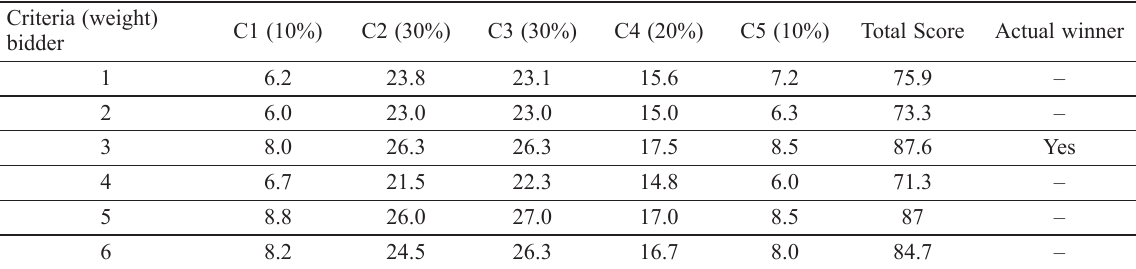
Table 1. Actual evaluation data of case project 1 Criteria (weight) bidder